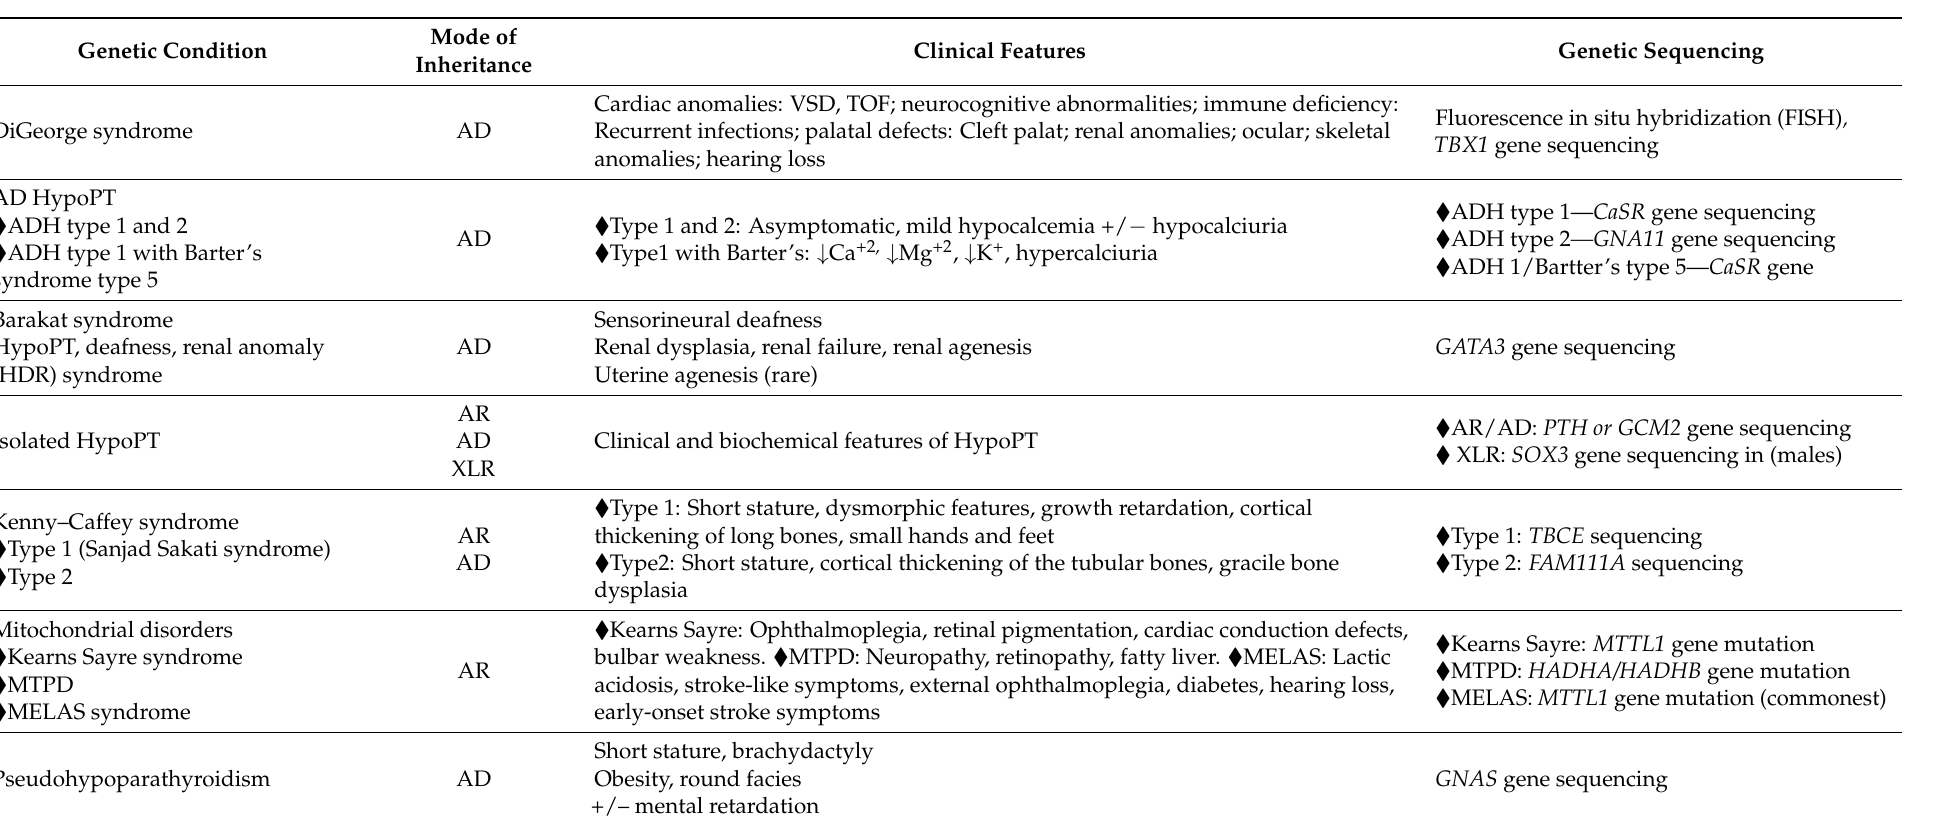
Table 2. Genetic Conditions Associated with HypoPT